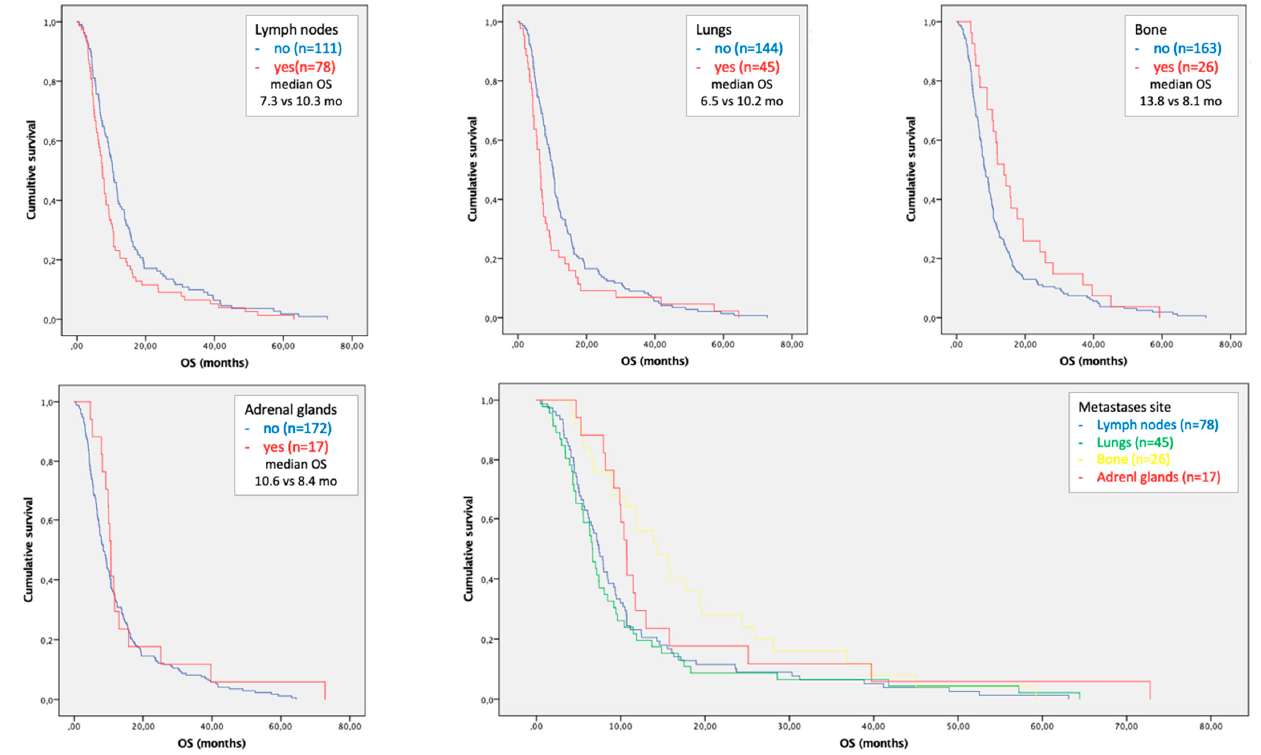
Figure 3. Kaplan–Meier curves of overall survival in patients with lymph node, lung, bone and adrenal gland metastases in the cohort of patients with single site of metastases. The last figure compares the survival curves of four overmentioned most frequent sites of metastases.